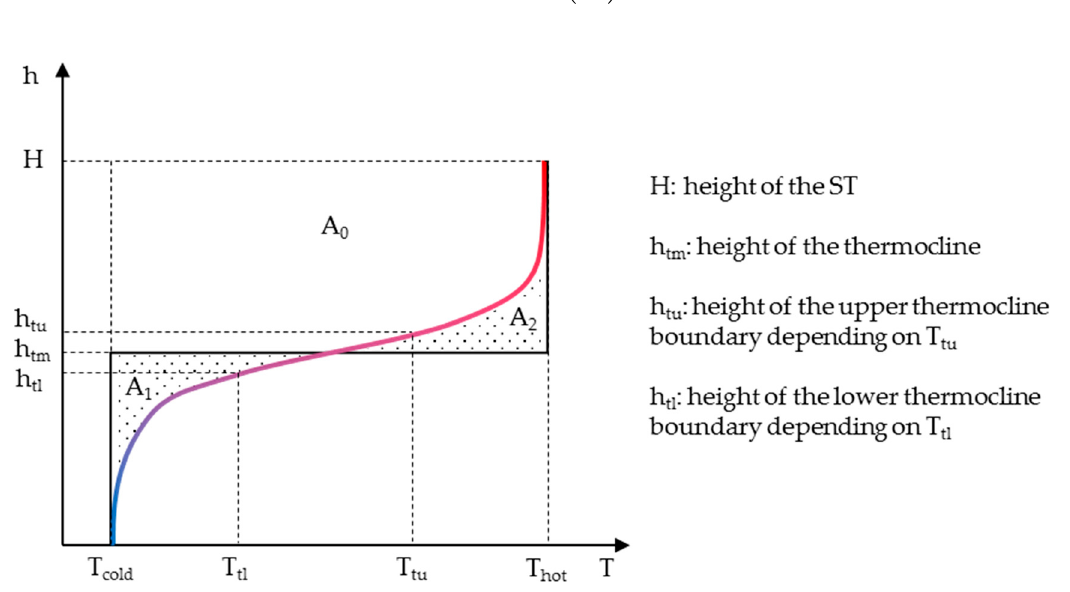
Figure 2. Illustration of variables used to define the validation criteria in a ST.